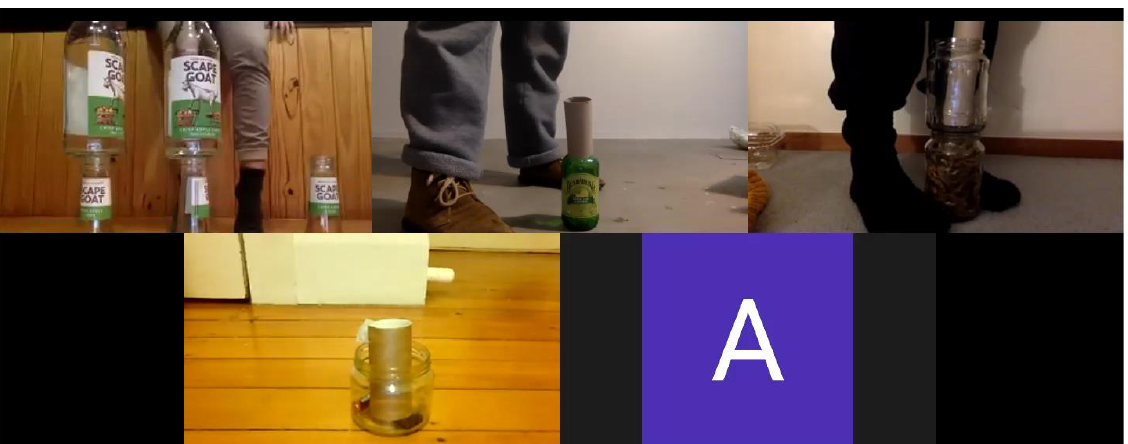
Figure 14: AND Lab and Politics of Togetherness’ Workshop with Guest Artist Fernanda Eugênio (BR/PT) 3R Dance Project hosted by Janaína Moraes and Joanna